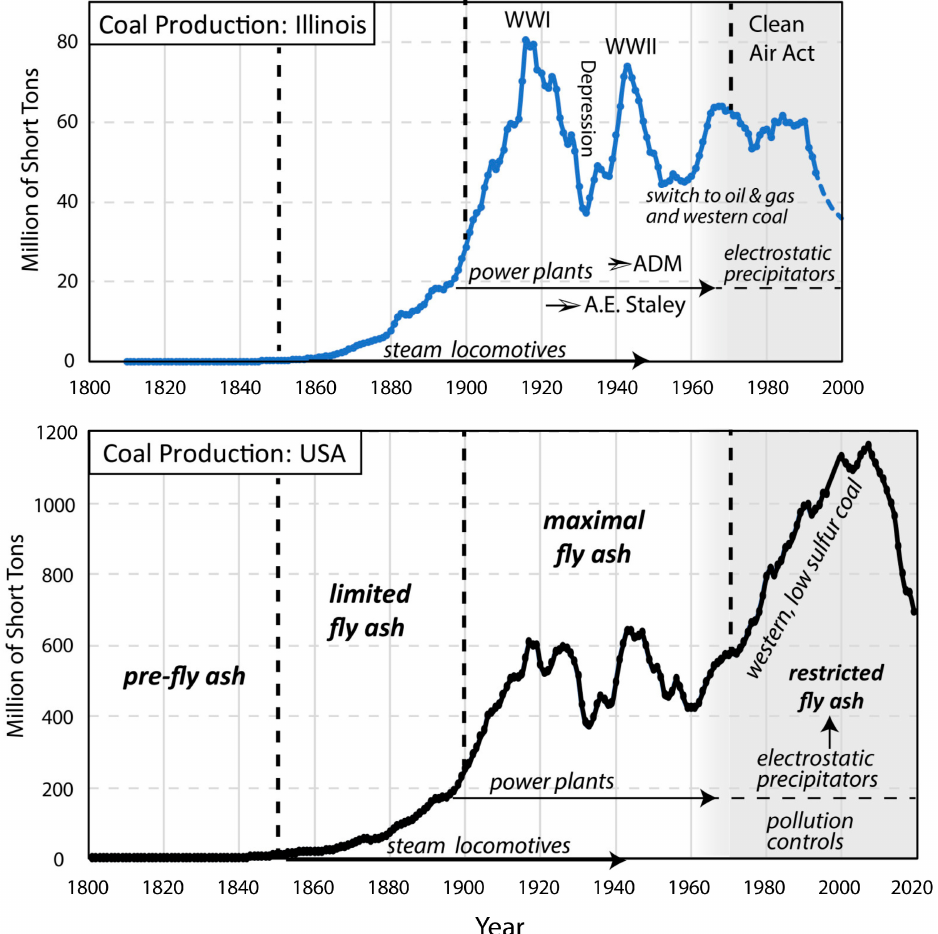
Figure 10. Coal production (3-year averages) in Illinois and the USA from 1800 to 2019. Data is from